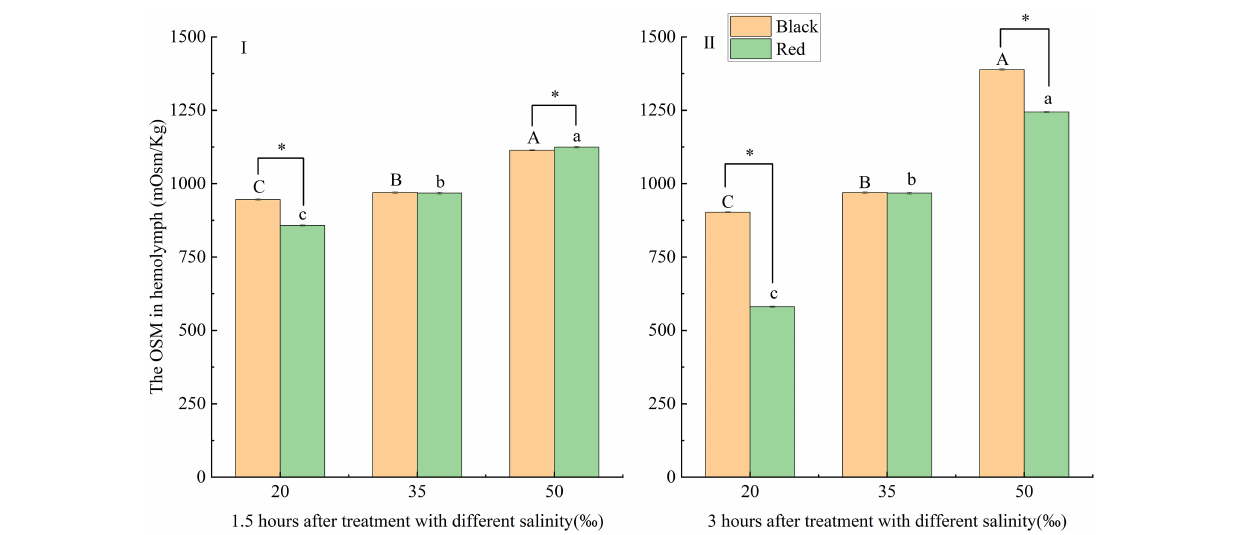
FIGURE 1 | Effects of acute ( I: 1.5 h; II: 3 h) salinity stress on hemolymph osmotic pressure (OSM) of black and red Pinctada fucata . Different capital letters (A, B, C) denotes that the hemolymph OSM of black P. fucata was significantly different at different salinities ( p < 0.05), while the same showed no significant difference ( p > 0.05). Different lowercase letters (a, b, c) denotes that the hemolymph OSM of P. fucata in red shell color varied significantly under different salinities ( p < 0.05), while the same showed no significant difference ( p > 0.05). The asterisk sign “ ∗ ” indicates that there are significant differences between the different shell colors at the same salinity ( p < 0.05).